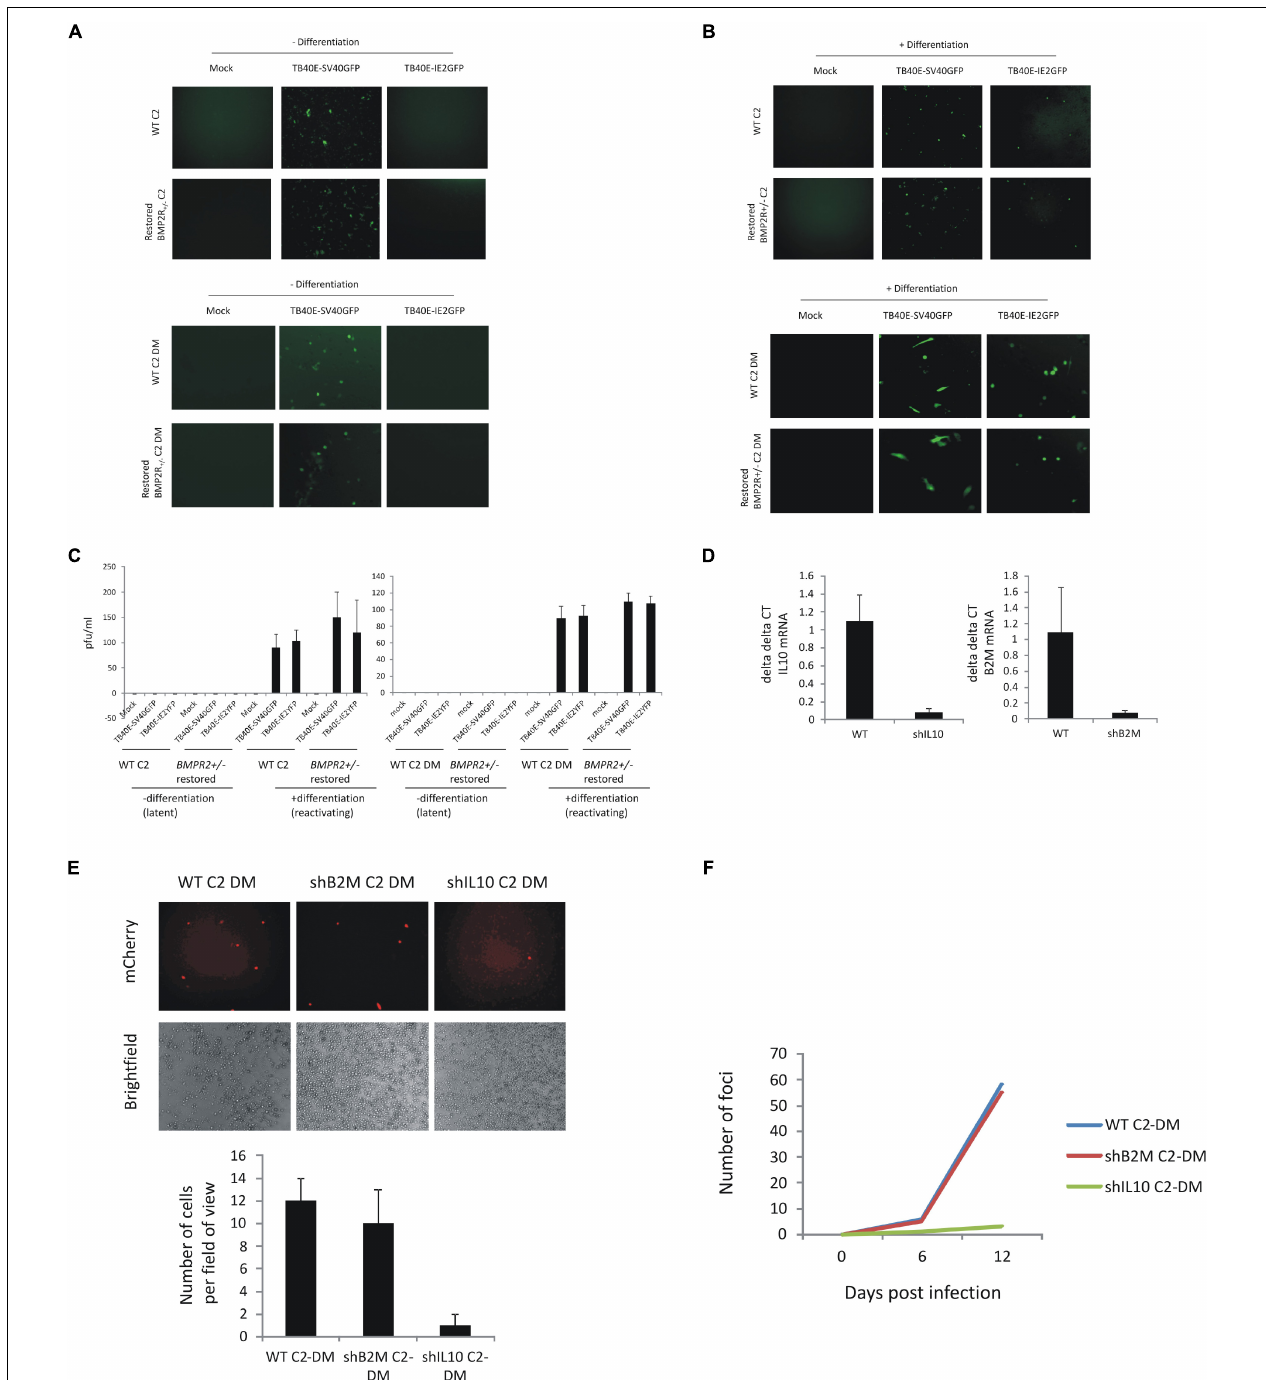
FIGURE 3 | C2 iPSCs retain the ability to support HCMV latency and reactivate virus after CRISPR/Cas9 editing and removal of cellular IL10 by lentiviral shRNA decreases HCMV maintenance and reactivation. C2 iPSCs or C2 iPSCs which have been mutated using CRISP-R directed gene editing ( BMPR2 ± C2 iPSCs or derived monocytes) were restored for WT BMP2 levels using 50 ng/ml BMP4 (BioTechne) before infecting with either TB40E-SV40GFP (MOI 5) or TB40E-IE2YFP (MOI 5) and during which time latency is supported for 4 days (A) before differentiating to induce reactivation (B) . Supernatants were collected and virion production was assessed by transferring to fibroblasts (C) . C2 iPSCs were also lentivirally transduced with lentiviral vectors delivering shIL10 or shB2M to cells. Following establishment of the C2 shIL10 and B2M knockout cell line, cells were differentiated into C2 DMs and validated by RTqPCR alongside WT C2 DMs (D) . WT C2 DM, B2M C2 DM, and shIL10 C2 DM cells were then latently infected with TB40E-GATA2-mCherry strain of HCMV (MOI 5) and analyzed by immunofluorescence 6 days later for the presence of the mCherry marker and fields of view were enumerated (E) . The release of virus was assessed following differentiation of the C2 DMs into C2 DCs and analyzing the formation of foci of infection with fibroblasts (F)